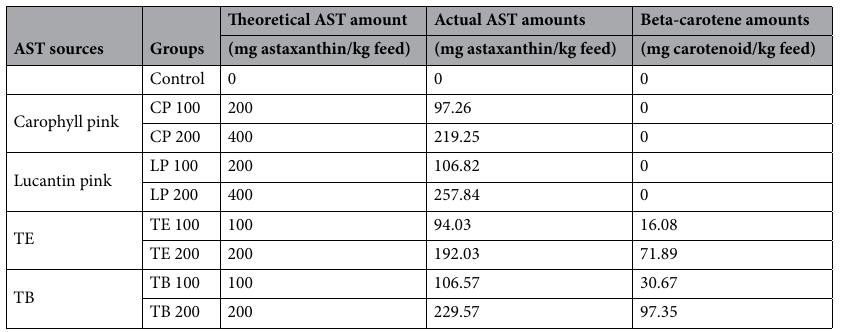
Table 3. Evaluation of the astaxanthin concentration of the experimental